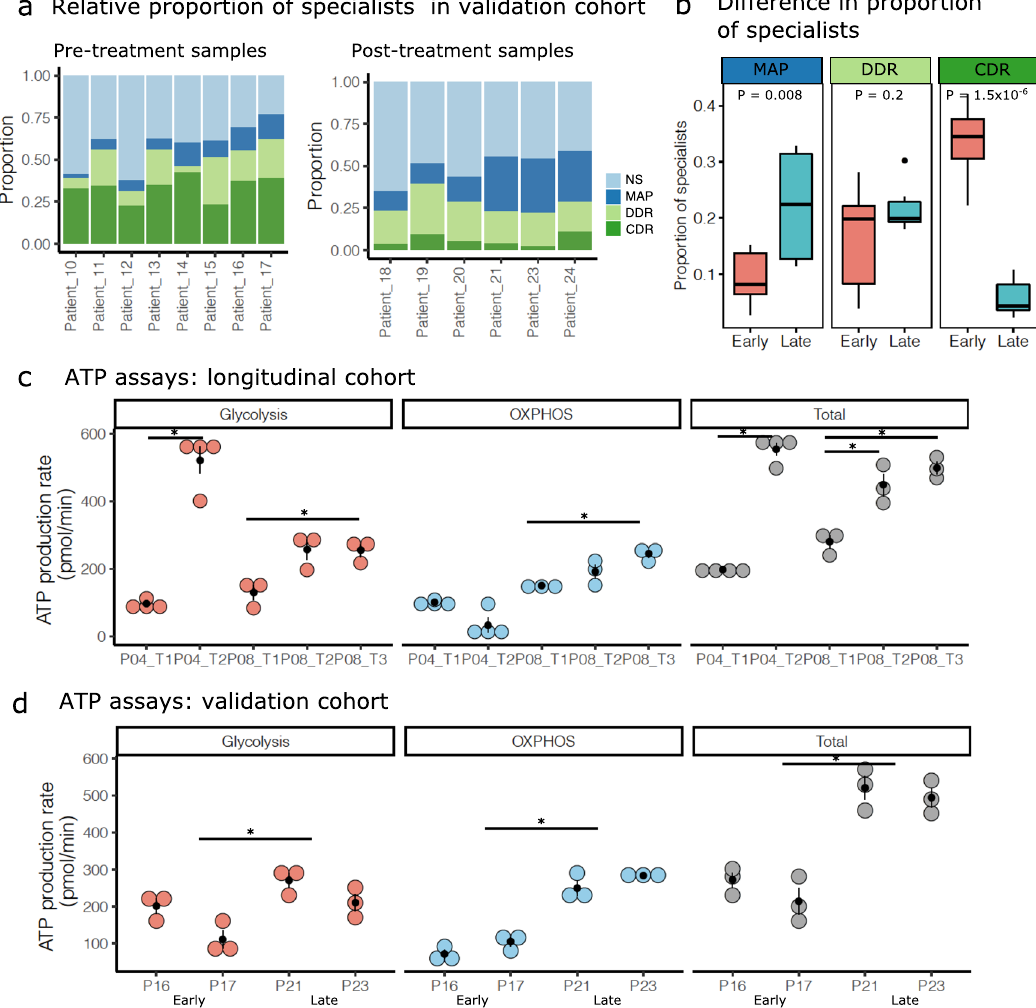
Fig. 4 Archetype shifts and experimental validation of metabolic capacity. a Stacked bar plots showing the proportion of specialists at biological tasks and non-specialists in the early/late patient cohorts. b Boxplots comparing the proportions of each task specialist between the early ( n = 8) and late ( n = 6) cohort samples. P value indicates signi fi cance in difference of means (two-tailed Student ’ s t test). The lower and upper hinges in the boxplot indicate 25th and 75th percentiles and middle indicates 50th percentile (median), while the whiskers extended over 1.5× interquartile range. c , d Dot plots displaying glycolysis, oxidative phosphorylation (OXPHOS), and total ATP production in cell lines developed using the malignant cells isolated from patients 4 and 8 ( c ) and patients 16, 17, 21, and 23 ( d ). Vertical black bars indicate standard error of the mean (SEM) across three independent biological replicates. The horizontal bars with an asterisk indicate a signi fi cant difference (FDR < 0.05) in mean ATP production rates. The comparisons were performed for all time points in ( c ), and the joint means between early and late cohort patients in ( d ). Source data for ATP production assay are provided as Source Data fi